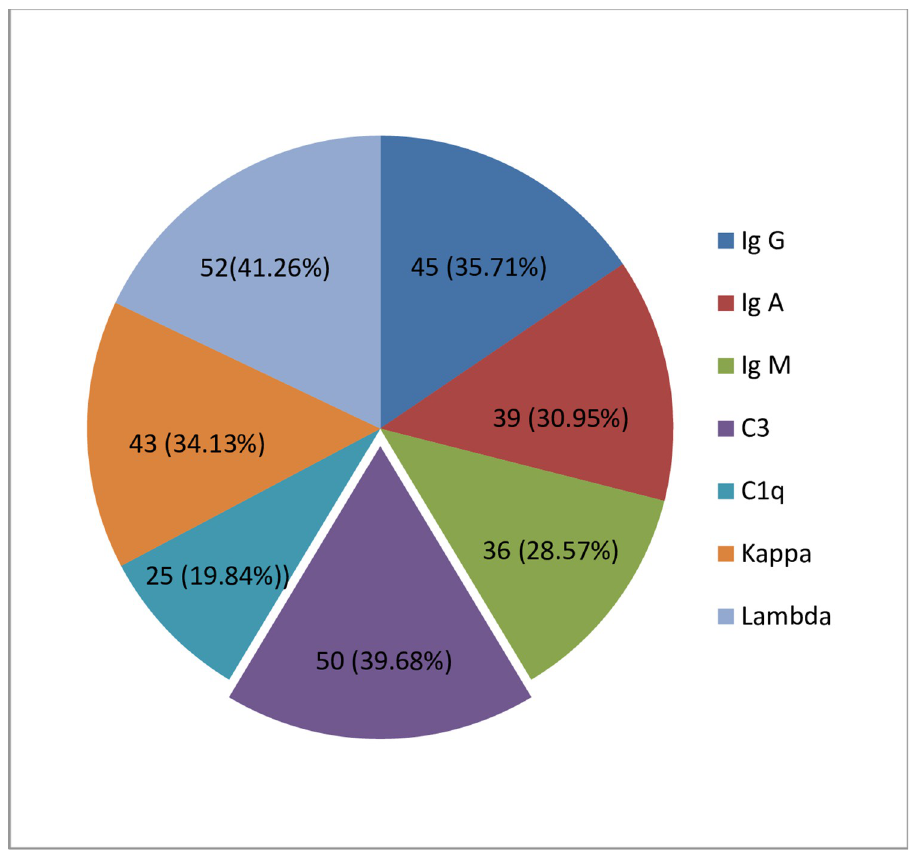
Fig 7. Percentage positivity of different immunoglobulins. Note: 2+ or more were considered positive on